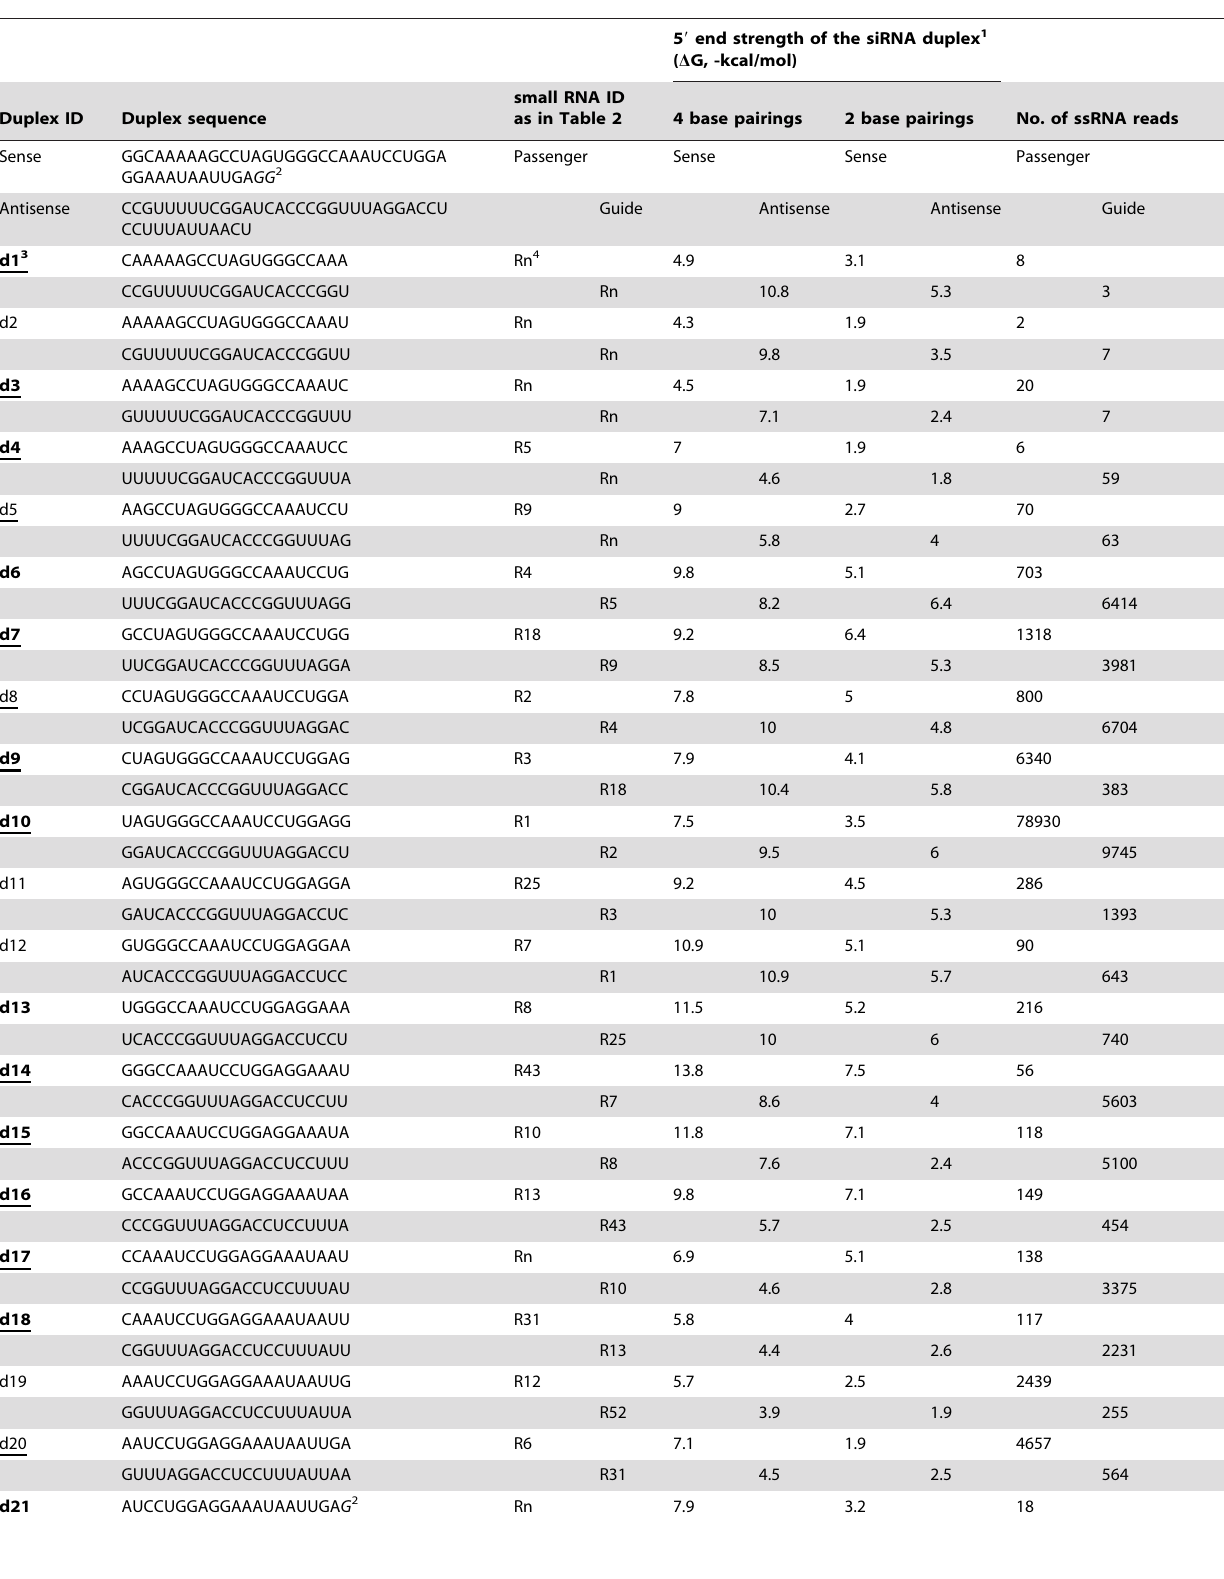
Table 3. Putative pART27-42 -derived siRNA duplexes, their 5 9 end strength, and the reads of passenger and guide ssRNAs.